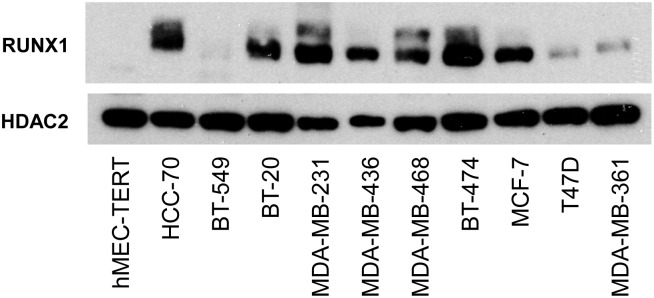
Expression of RUNX1 in human breast cancer cell lines.RUNX1 expression by western blot on a panel of human breast cancer cell lines with basal–like (HCC-70, BT-549, BT-20, MDA-MB-231, MDA-MB-436, MDA-MB-468) and luminal-like (BT-474, MCF-7, T47D, MDA-MB-361) features. HDAC2 used as a loading control. hMEC-TERT; immortalized human mammary epithelial cells.